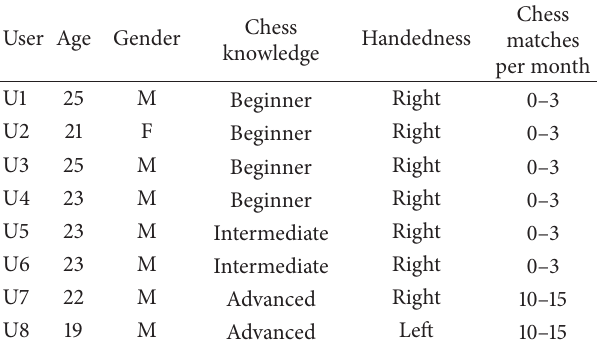
Table 1: Demographic data from